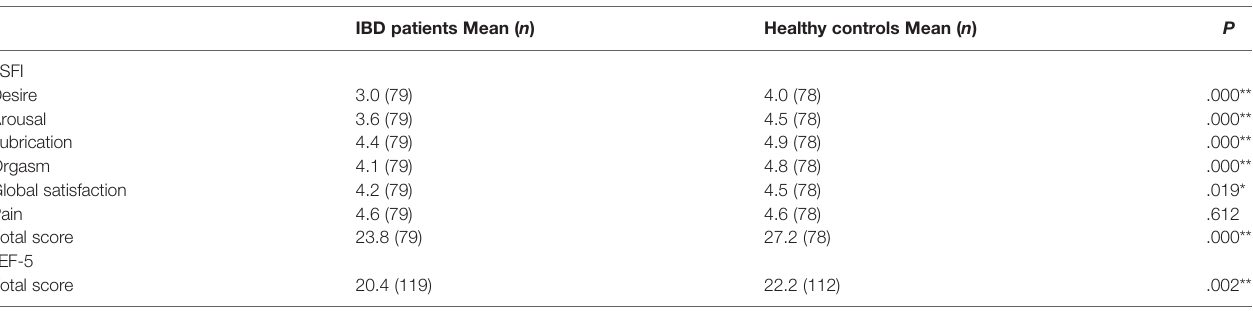
Mean score, number of matched individuals, paired t-test p-value. *P <.05, **P <.01. FSFI, female sexual function index; IBD, in fl ammatory bowel disease; IIEF-5, a simpli fi ed version of the international index of erectile function.